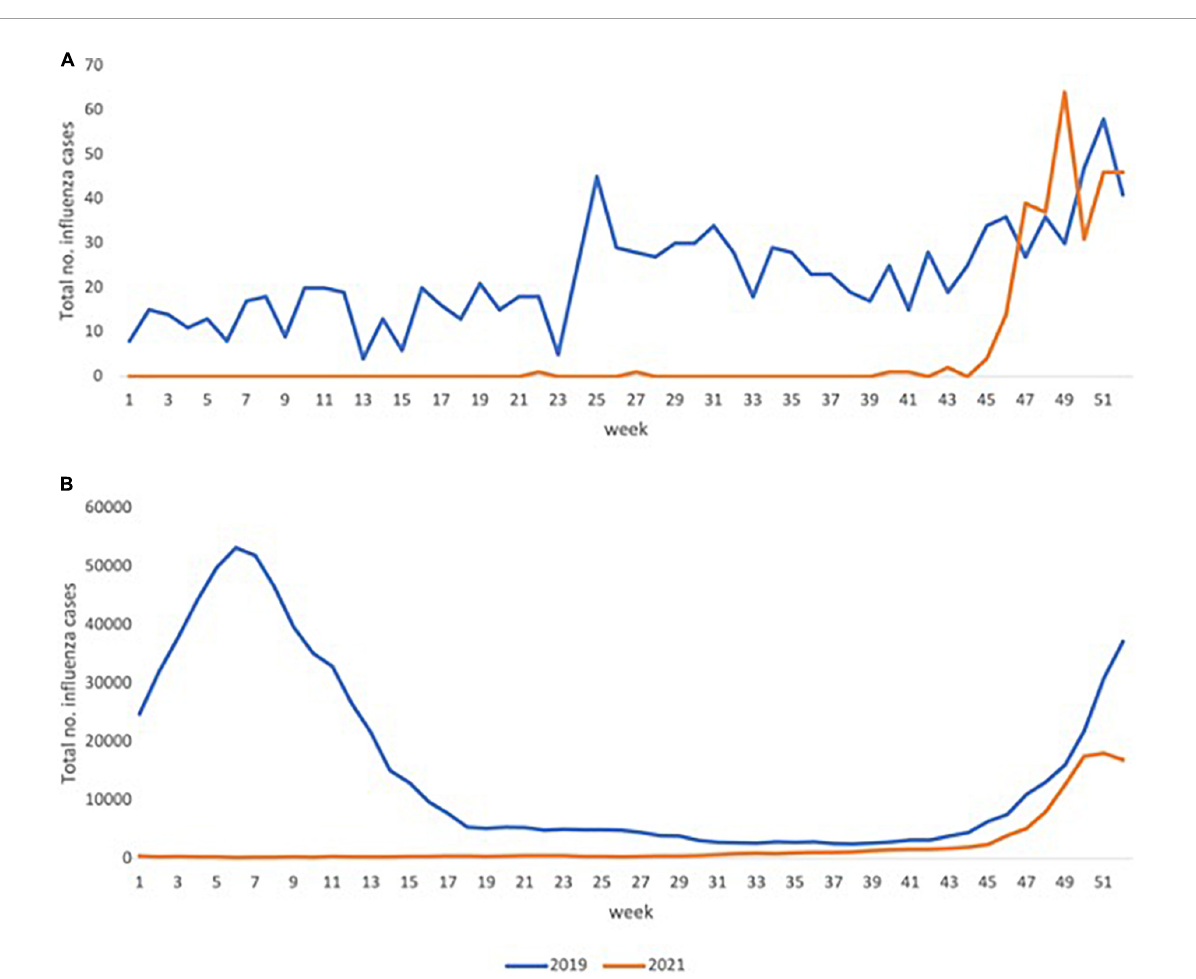
FIGURE4 Total number of cases of influenza reported for Malaysia and globally according to Flunet surveillance for 2019 and 2021. The total number of influenza cases reported to the World Health Organization web-based tool for influenza virological surveillance (FluNet). The above figures depict the total number of weekly reported cases for Malaysia (A) and globally (B) for the years 2019 (blue) and 2021 (orange). Data obtained from FluNet